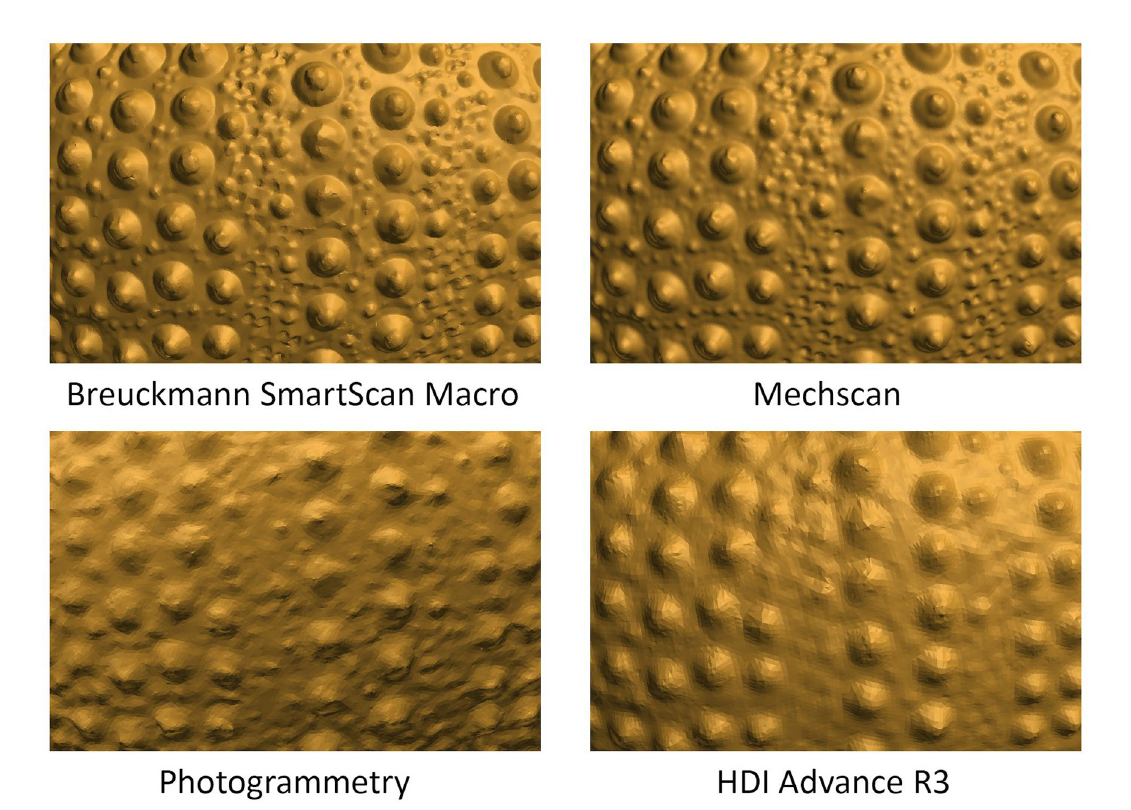
Fig. 6.6. Detailed view of the sea urchins digitised with different equipment. The goal was to digitise the small punctures on the surface as these aid in identifying the species of the sea urchin.